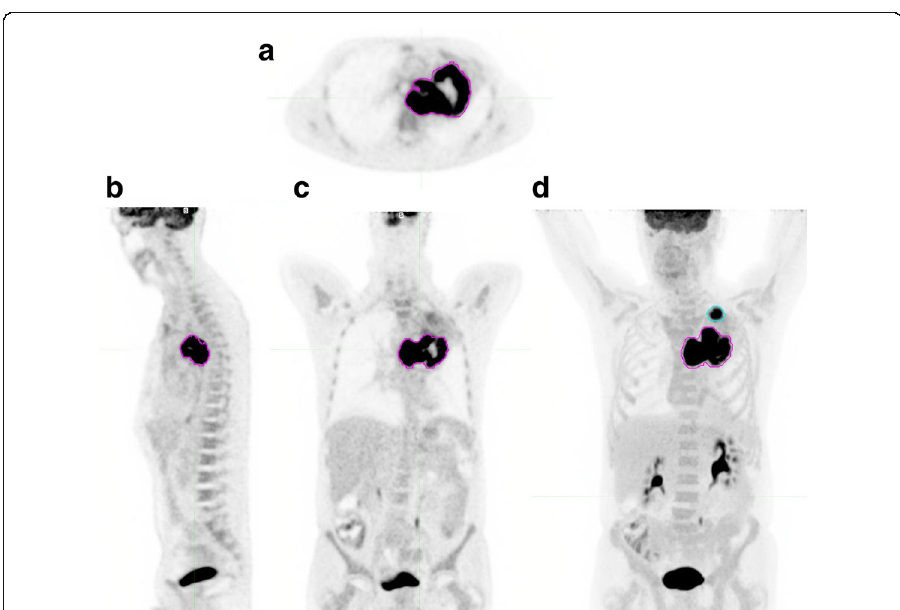
Fig. 1 Whole-body PET images of a 59 year-old male with newly diagnosed squamous cell carcinoma, stage IIIB (T4N2M0). This study was performed for initial staging. Colored regions of interest (ROIs) show the tumor contours. The MTVwb in mL is the sum of tumor volumes in all ROIs. Axial image ( a ), sagittal image ( b ), coronal image ( c ) and maximal intensity projection image ( d